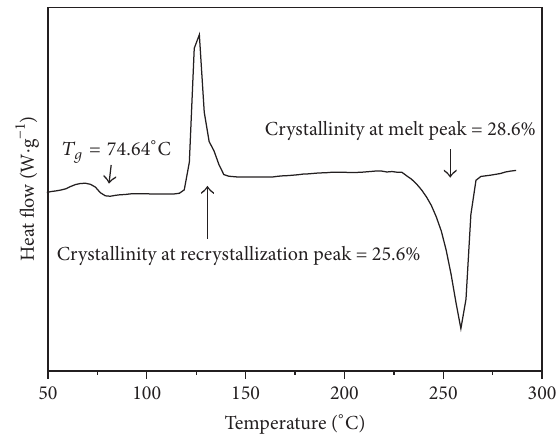
Figure 8: DSC heating trace of as-spun PET bristle, indicating 𝑇 𝑔 ≈ 75 ∘ C and a recrystallization temperature at around 125 ∘